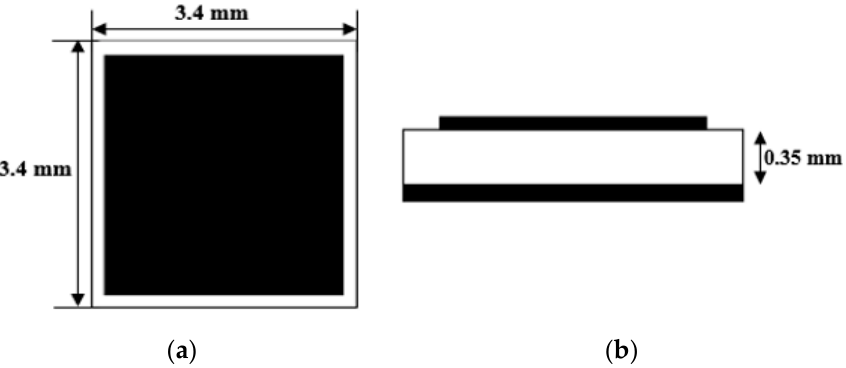
Figure 5. Electromagnetic bandgap (EBG) unit cell geometry. ( a ) Front view; ( b ) bottom view.